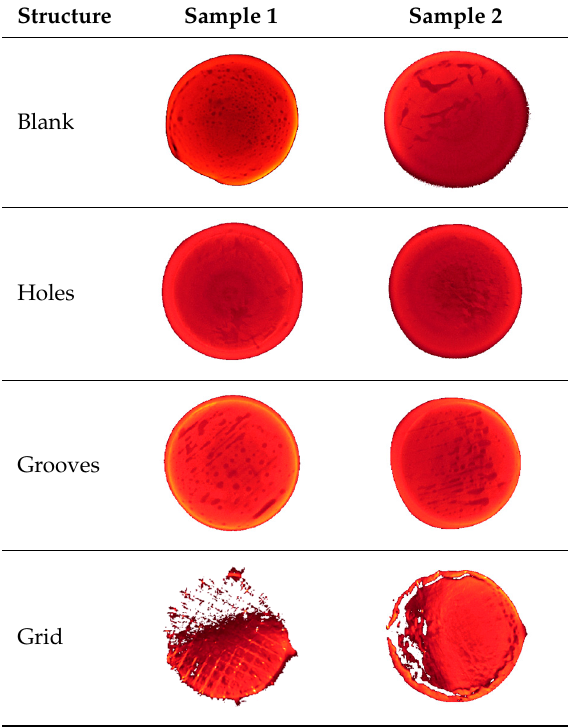
Table 3. µ -CT images of the carbide / filler metal interface for the four surface structures. Table 3. μ‐ CT images of the carbide/filler metal interface for the four surface structures. Table 3. μ‐ CT images of the carbide/filler metal interface for the four surface structures. Table 3. μ‐ CT images of the carbide/filler metal interface for the four surface structures. Table 3. μ‐ CT images of the carbide/filler metal interface for the four surface structures. Table 3. μ‐ CT images of the carbide/filler metal interface for the four surface structures. Table 3. μ‐ CT images of the carbide/filler metal interface for the four surface structures. Table 3. μ‐ CT images of the carbide/filler metal interface for the four surface structures. Table 3. μ‐ CT images of the carbide/filler metal interface for the four surface structures.